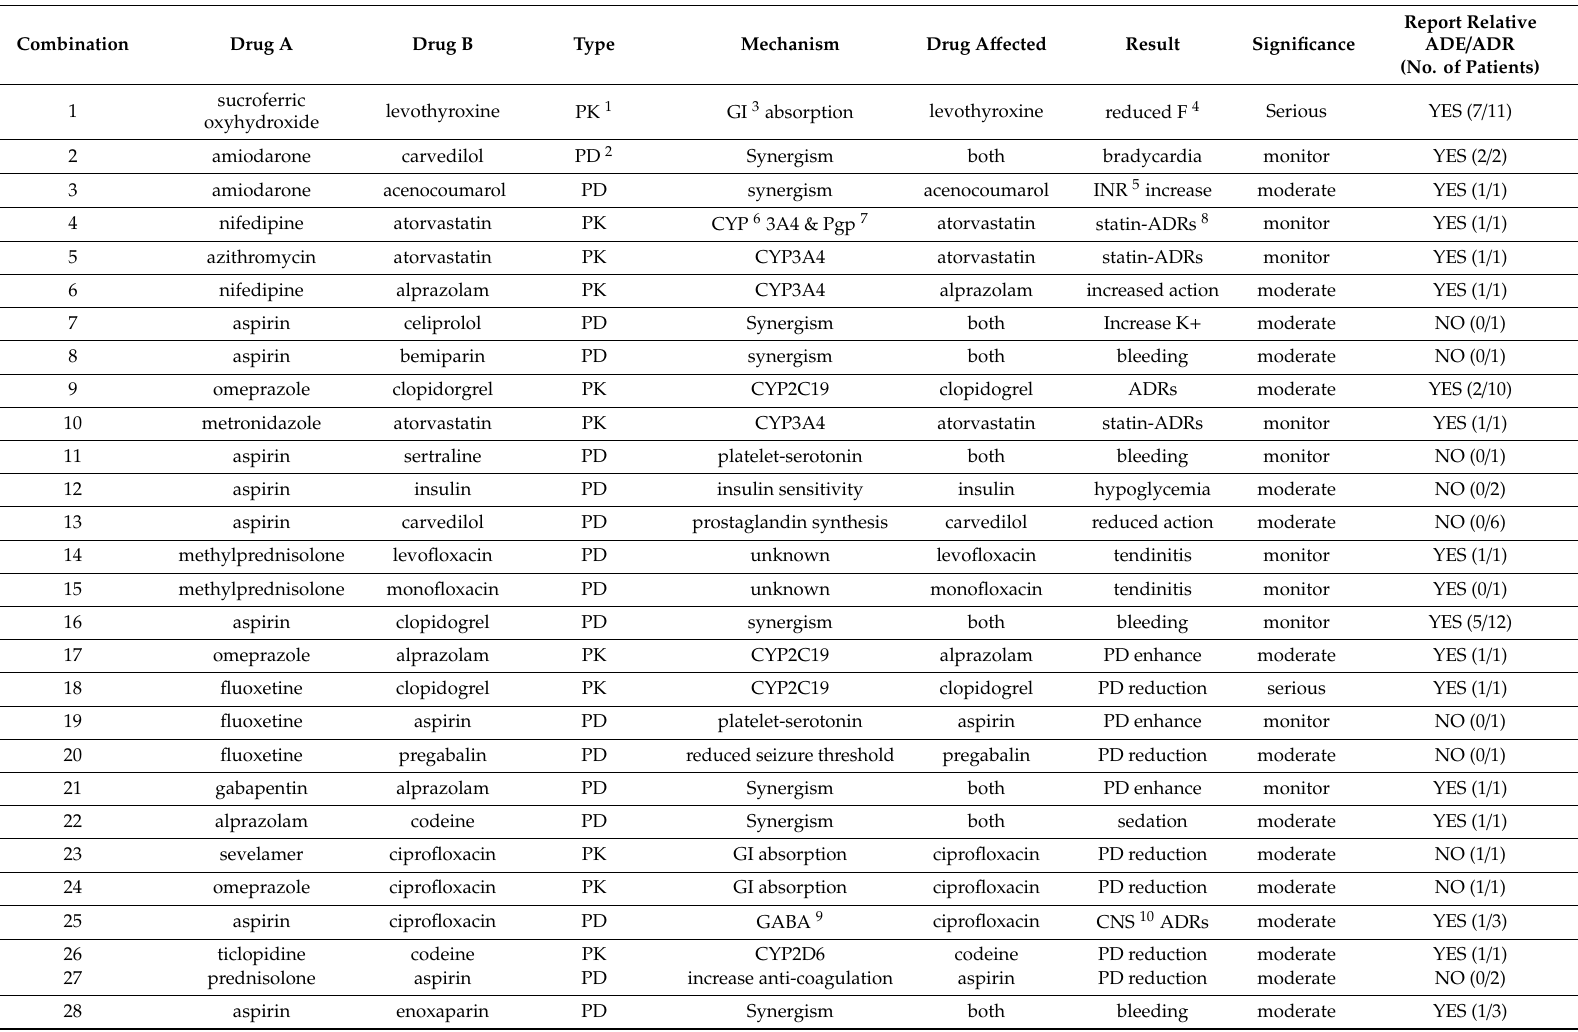
Table 4. Drug–drug interactions detected among medication regimens of ESRD patients, their clinical significance, and cases of reports of relative ADE / ADR.